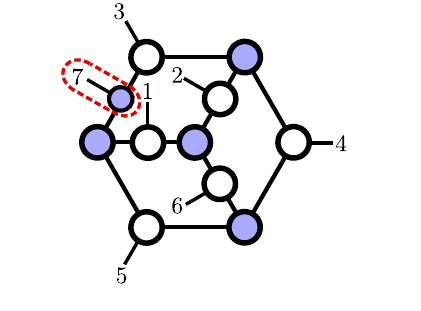
Fig. 2 An MHV example Table 1 The evolution of the geometric